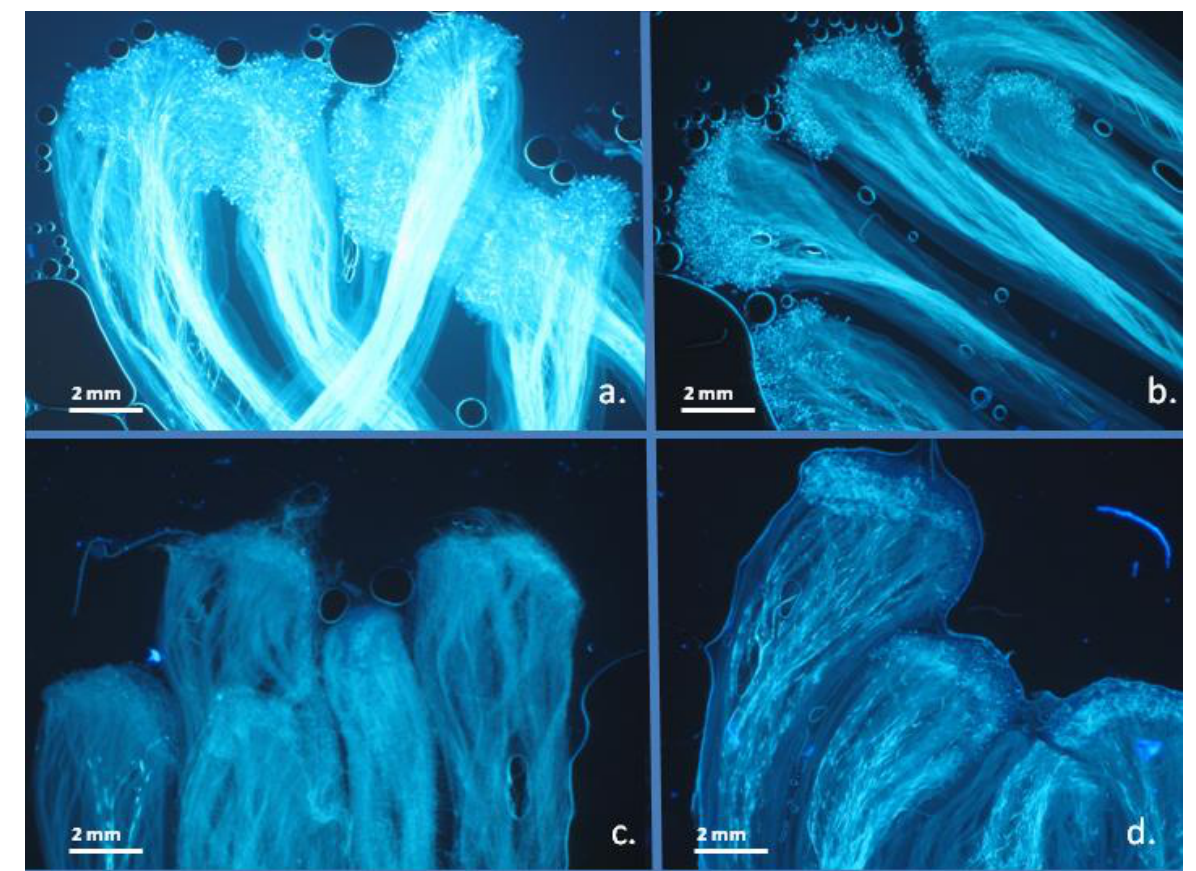
Figure 3. Pollen grains germinating on the stigmas. ( a ) — open-pollination + titanium organic complex, five pollinated stigmas, a large number of pollen tubes visible in lower part of pistil style; ( b ) — open-pollination, five pollinated stigmas; ( c ) — self-pollination, visible single pollen grains and single pollen tubes; ( d ) — self-pollination + titanium organic complex, visible pollen grains and numerous pollen tubes; the pictures were made with the use of Light Microscope Discovery V12 Zeiss Stereo 3D and Fluorescence Microscope Imager M2 1022448558 1/1 Zeiss Axio.